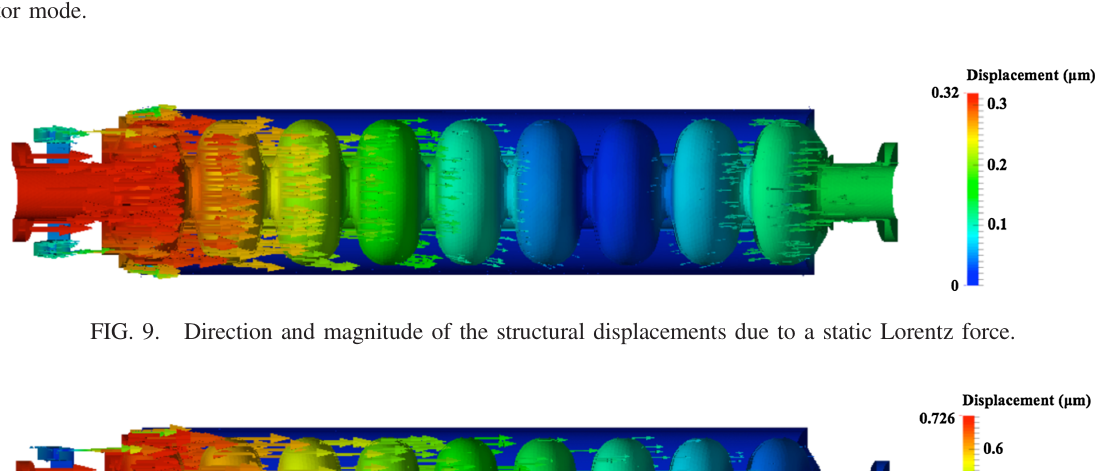
8. Direction and magnitude of the electromagnetic pressure (a.u.) color coded on a linear scale for the fundamental 1.3 GHz accelerator mode.